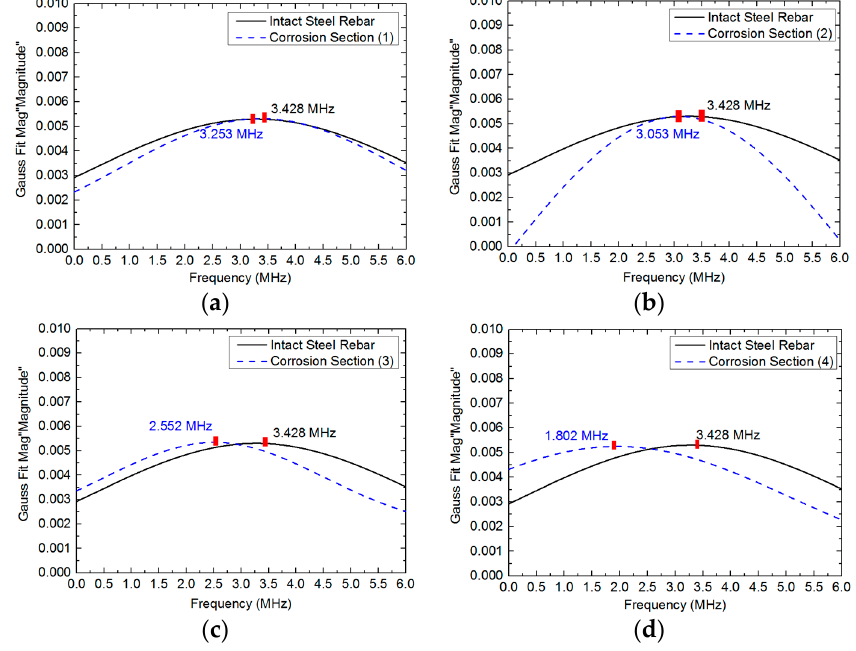
Figure 9. The frequency domain responses at four different corrosion sections on steel rebar after ACT.